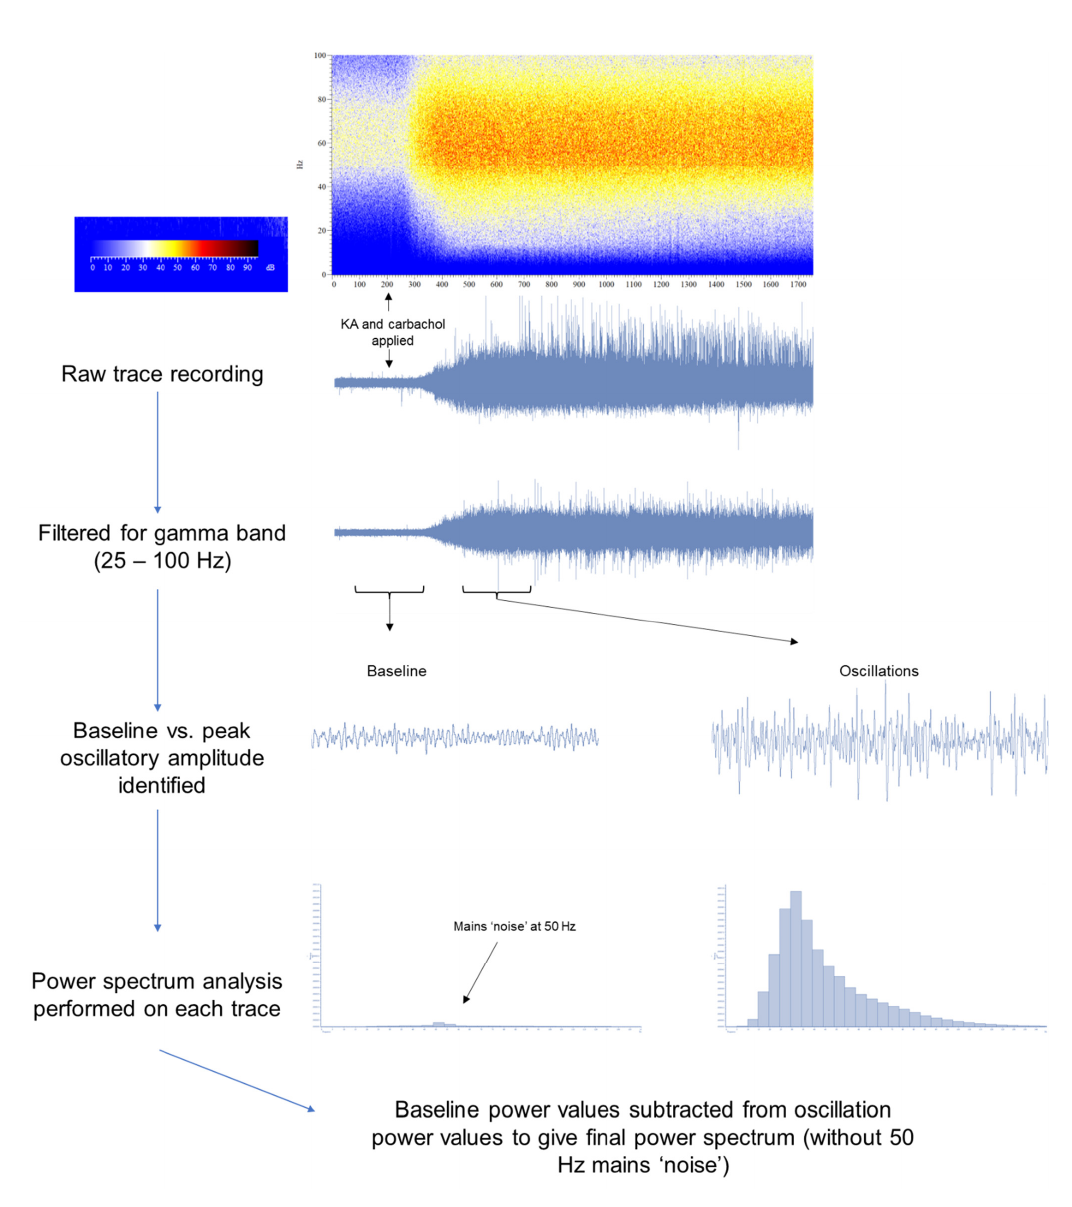
Figure 1. The analysis protocol used to acquire oscillatory power values from each slice recording. The raw trace recording from each PFC slice (illustrated by the example spectrogram and waveform) was filtered for the gamma (25–100 Hz) band. From the filtered trace, 100–300 s sections of the baseline and peak oscillatory amplitude were identified. After a power spectrum analysis was performed on the baseline trace and oscillation trace, the baseline power values were subtracted from the oscillation values to remove any mains ‘noise’ present at 50 Hz. The final power spectrum values were then produced from this slice and used to calculate amplitude and area power for each recording.